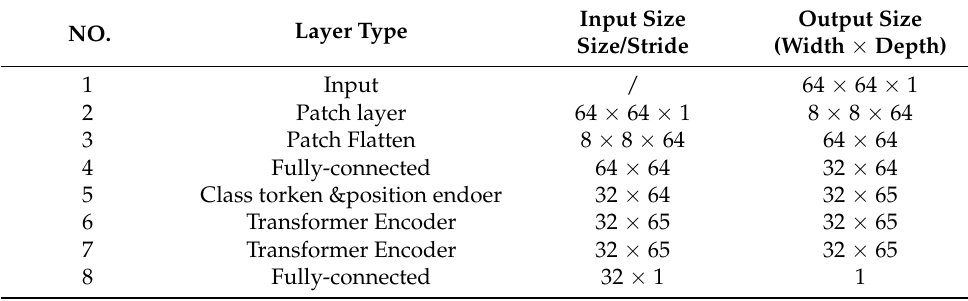
Table 1. Details of the proposed